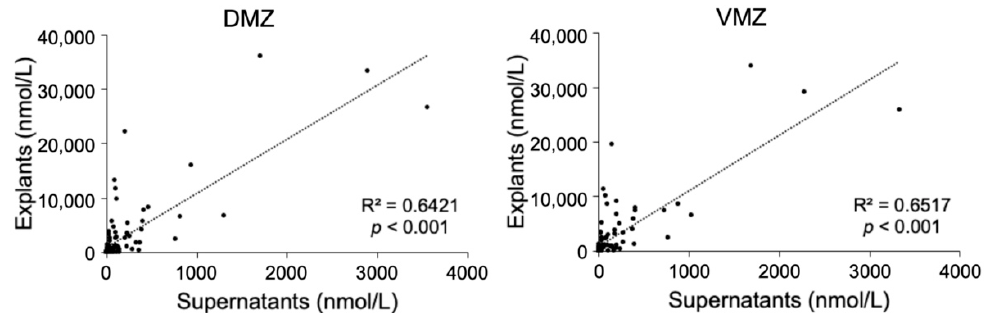
Figure 1. Correlations of the hydrophilic metabolites in explants and supernatants. 2.1.2. The DMZ and the VMZ Had, Respectively, High Amounts of Glycolysis ‐ and